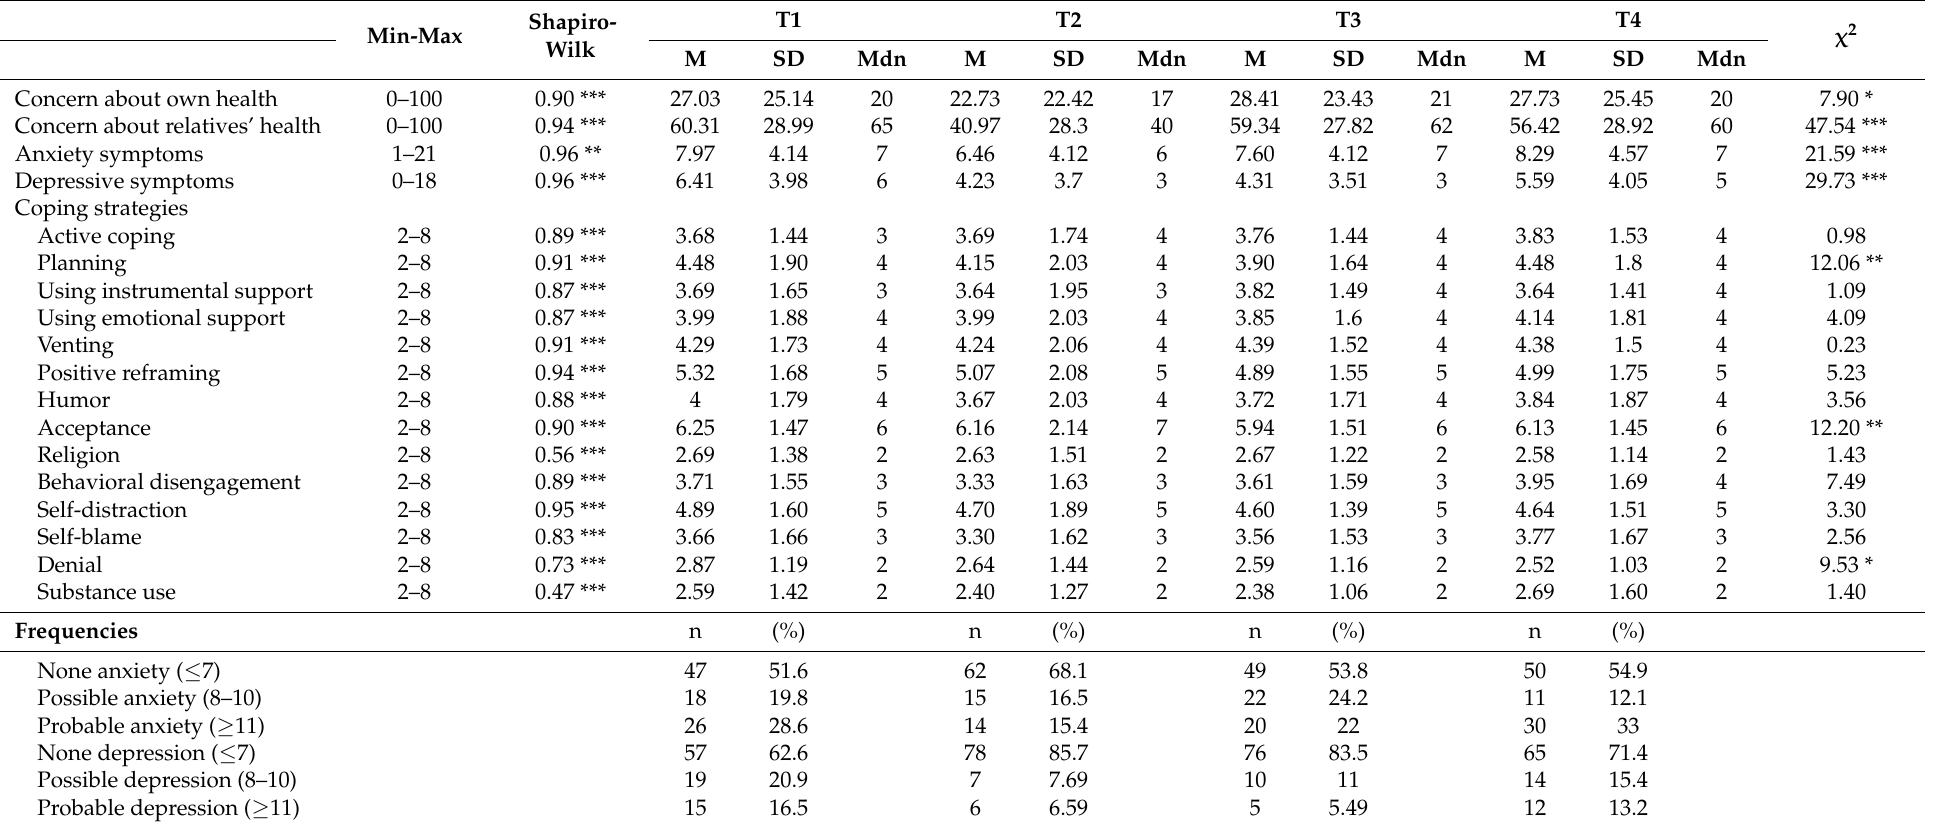
Table 2. Comparison of coping strategies, health concerns and anxiety–depressive symptoms scores of French students at different times during the COVID-19 pandemic (two periods of lockdown and two unlockdown periods) with Friedman test of non-parametric ANOVA (N =